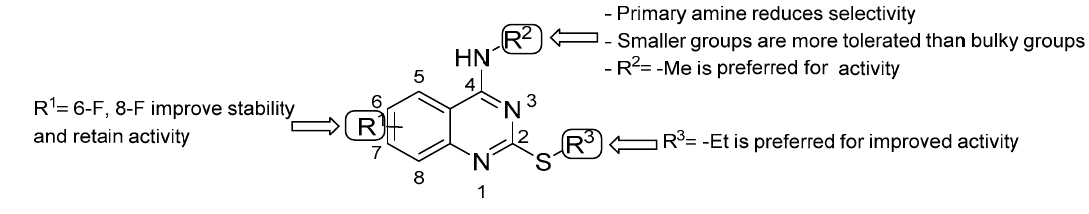
Figure 14. The chemical structure of Zolpidem and SARs of its analogues.